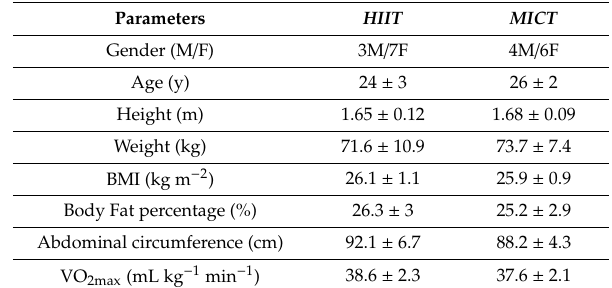
Table 4. Baseline characteristics of the two groups of volunteers participating in HIIT or MICT protocols. Parameters